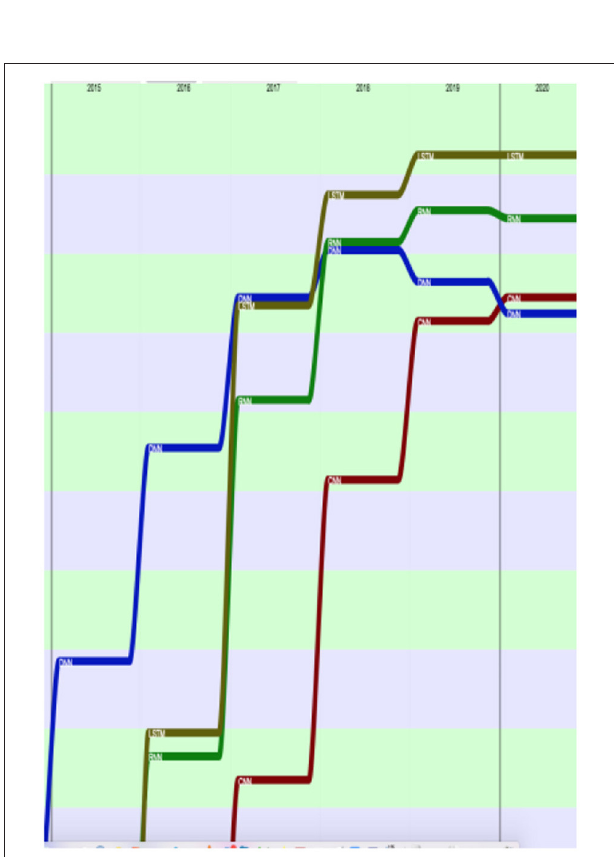
FIGURE 33 | Evolution of the terms “HMM” (in green) and “Neural Network” (in blue) over the past 30 years (1990 to 2020) according to their presence in the papers.